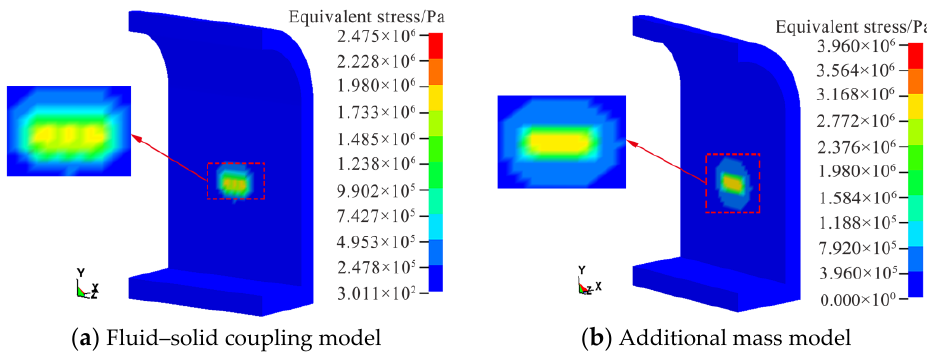
Figure 5. Equivalent stress clouds under different collision models, where: Local enlargement of the ice−tunnel impact zone is performed.